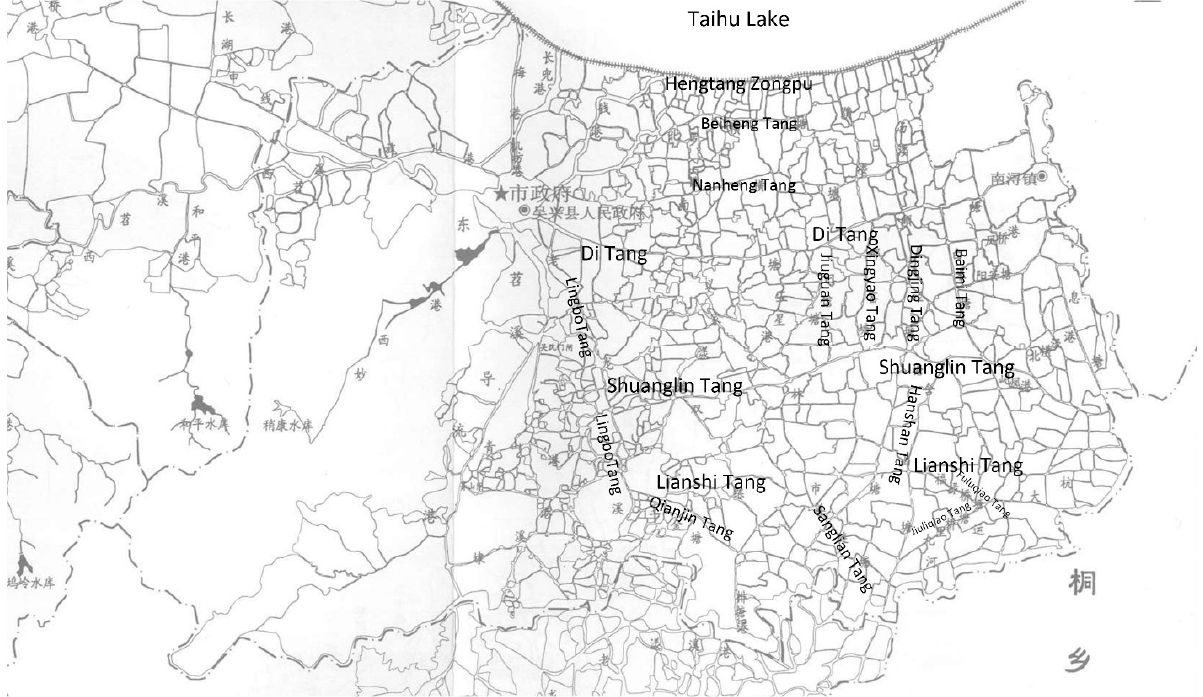
Figure 3. Map of the current water system of Huzhou City and location of Tangs [40].